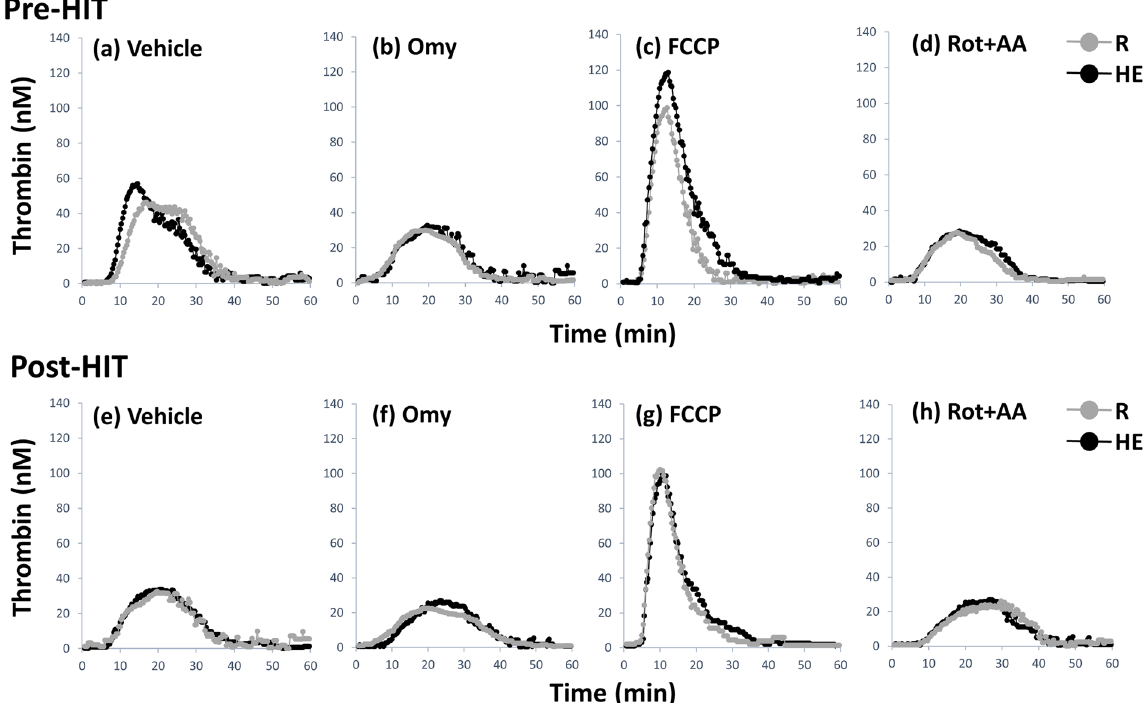
Figure 7. The calibrated, automatic thrombinographic analysis of high-intensity interval training ( HIT ) effect on dynamic thrombin generation in platelet-rich plasma (PRP). Pre-HIT , before HIT; Post-HIT , after HIT; R , resting; HE , hypoxic (12%O 2 ) exercise test; Omy , oligomycin; FCCP , carbonyl cyanide-p-trifluoromethoxyphe nylhydrazone; Rot , rotenone; AA , antimycin